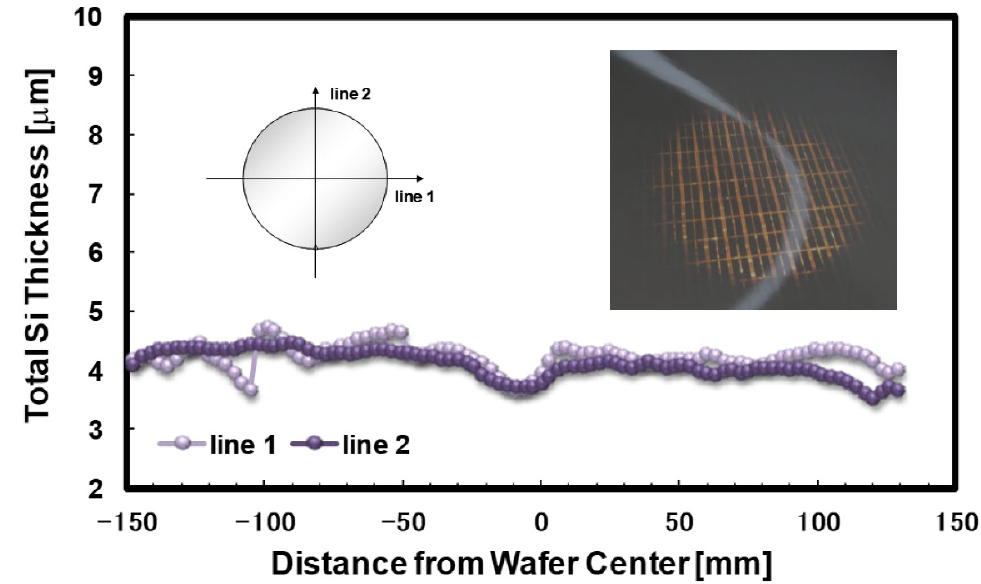
Figure 8. Total thickness of 300 mm DRAM wafer after thinning to 4 µ m as a function of wafer position from bottom (notch) to top and from left to right. Light transparency occurs at 4 μ m where dark region represents high-density device area.